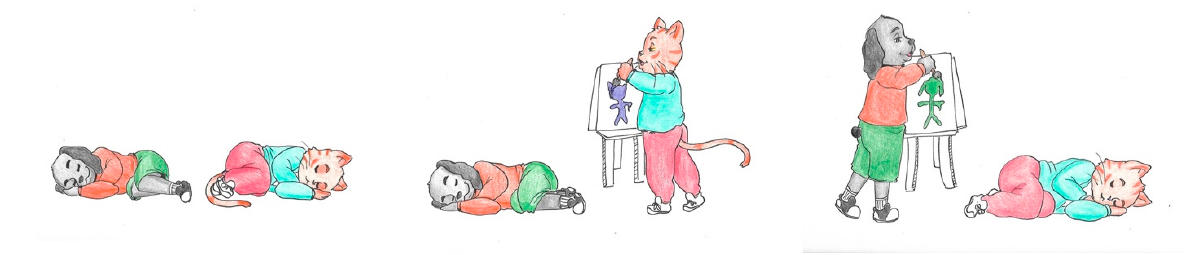
Figure A40. Filler stimulus 15. El perro manda al gato a pintar, y lo hace.